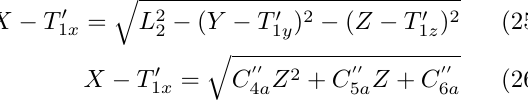
Figure 26: Cartesian stiffness in the X-direction as function of the Y-coordinate at fixed X=1.0 and Z=0.3, 0.5, 0.7.